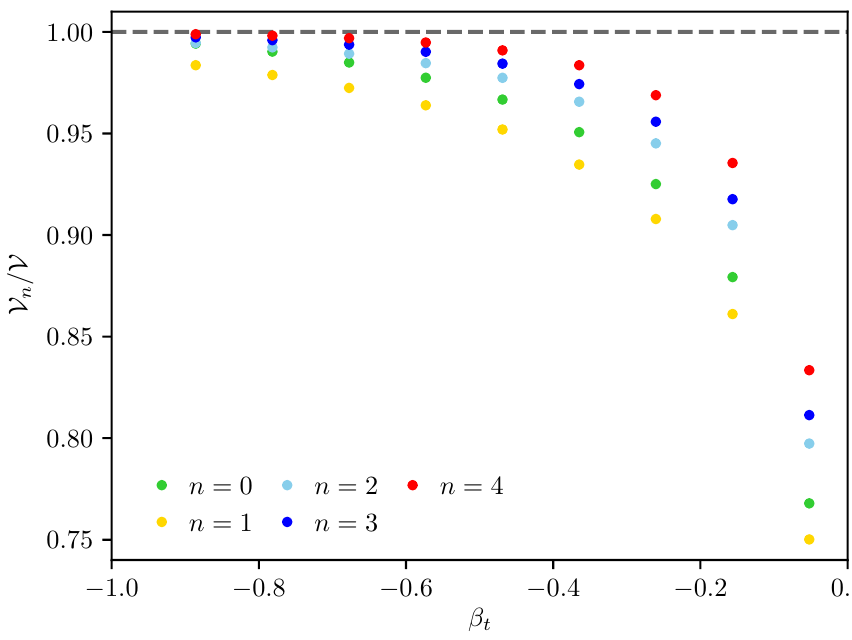
Figure 3 . Comparison of exact virtual contributions V with the expansion in the large top quark mass limit V n from [17] for fixed scattering angle cos( θ ) ≈ 0 . 052 . The range of the horizontal axis − 1 ≤ β t ≤ 0 corresponds to the energy range ( m Z + m H ) 2 ≤ s ≤ 4 m 2 threshold and top quark pair